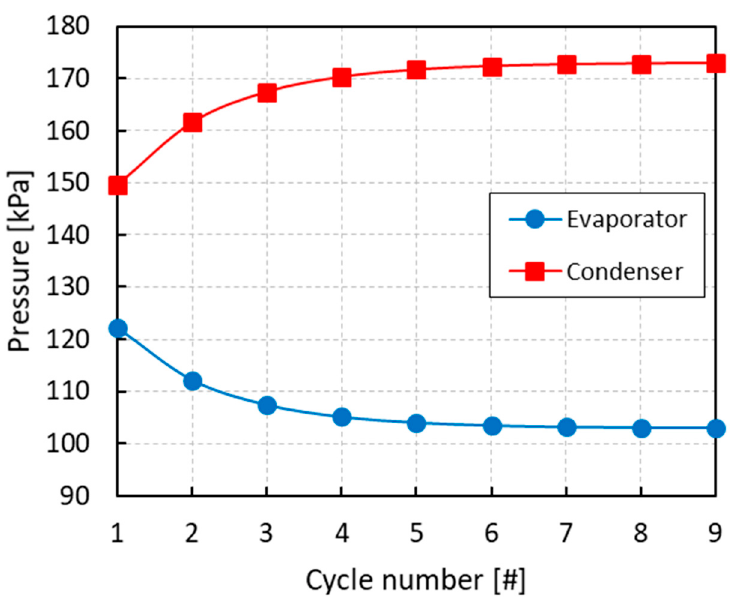
Figure 3. Evolution of the pressure in the evaporator and condenser with the cycle number for an initial overall mole fraction of ethanol z 2 = 0.75.